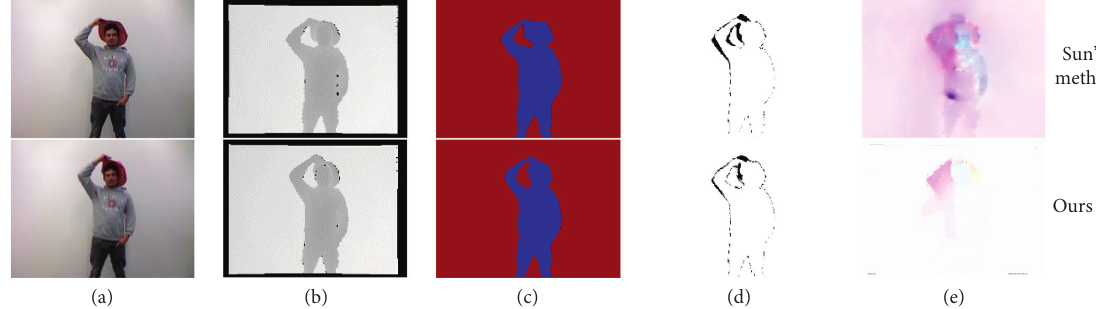
Figure 6: Pose 1 in “Hat” sequence.” Input two consecutive frames about Pose 1 in “Hat” sequence, segment them into 2 regions (human body with hat and background), and estimate the occlusion and scene flow. (a) RGB images. (b) Depth images. (c) Segmentation K � 2. (d) Occlusions. (e) Motion.